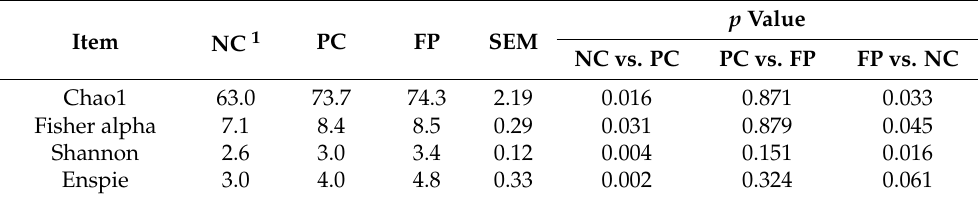
Table 4. Effect of fermented products produced by B. licheniformis on the bacterial species richness and evenness in the cecal digesta of broilers.